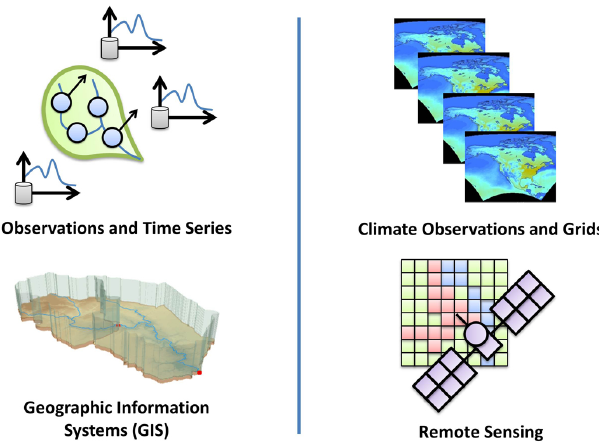
Fig. 1. The digital divide between hydrologic and atmospheric sci- ence